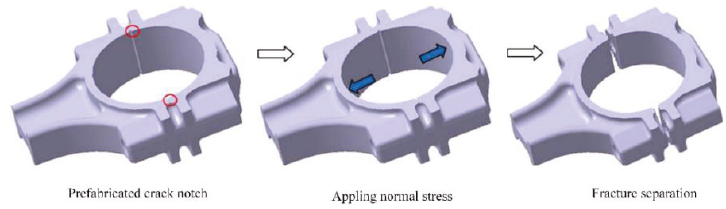
Figure 1. Connecting rod fracture-split process.